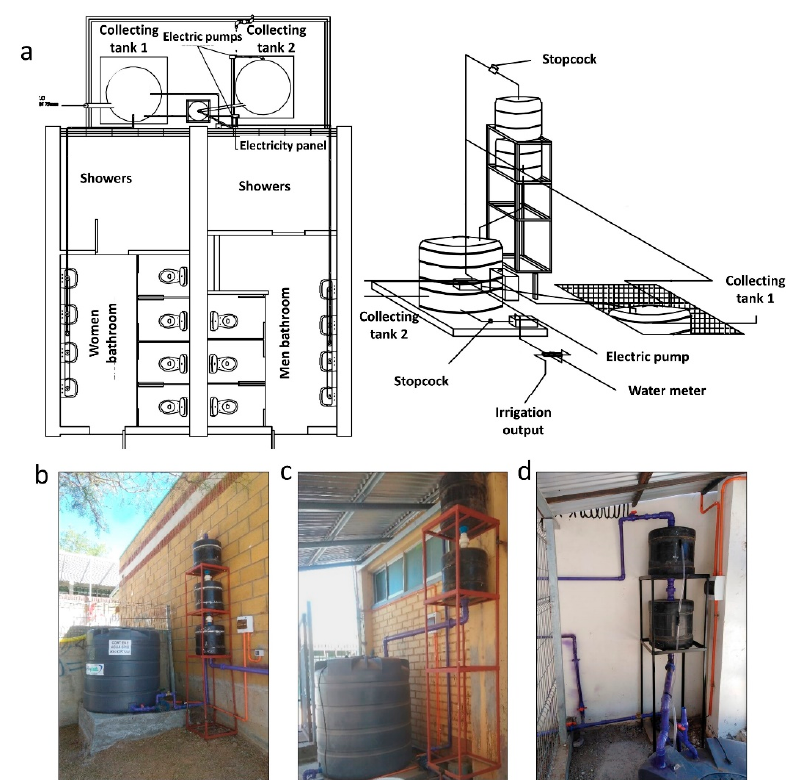
Figure 1. Greywater treatment systems in rural schools. ( a ) Top and front view of the design drawing of the treatment systems; Photographs of the actual systems in ( b ) Alejandro Chelén School; ( c ) El Guindo School; and ( d ) Pedro de Valdivia School .